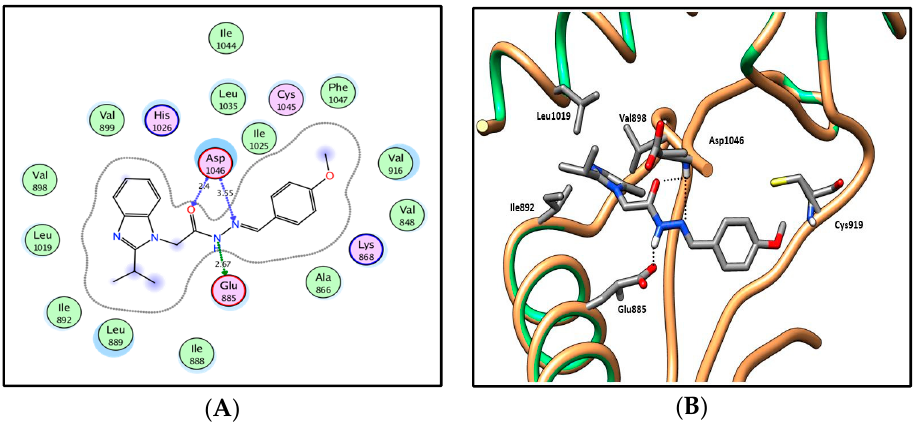
Figure 10. 2D diagram ( A ) and 3D representation ( B ) of compound 13d showing its interaction with the VEGFR-2 active